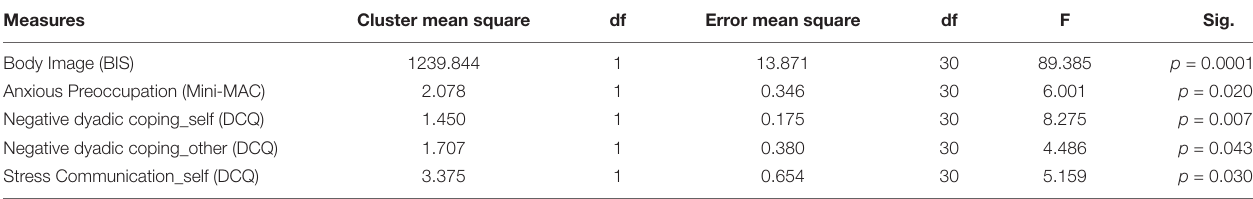
TABLE 3 | Cluster Analysis on patients’ subsample: